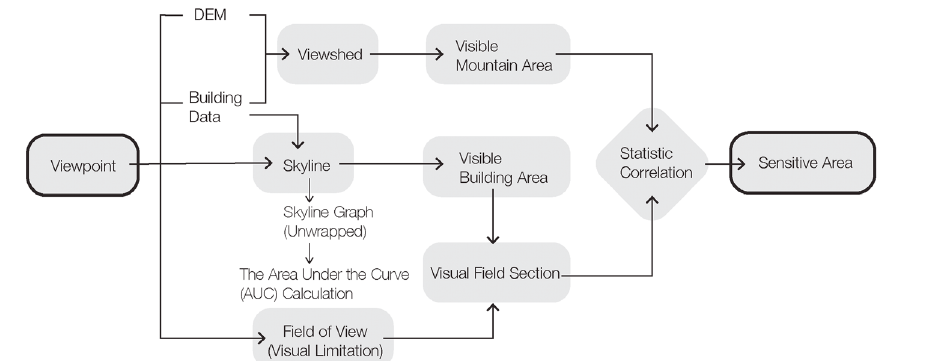
Fig. 5 Research Methodology (Source: the